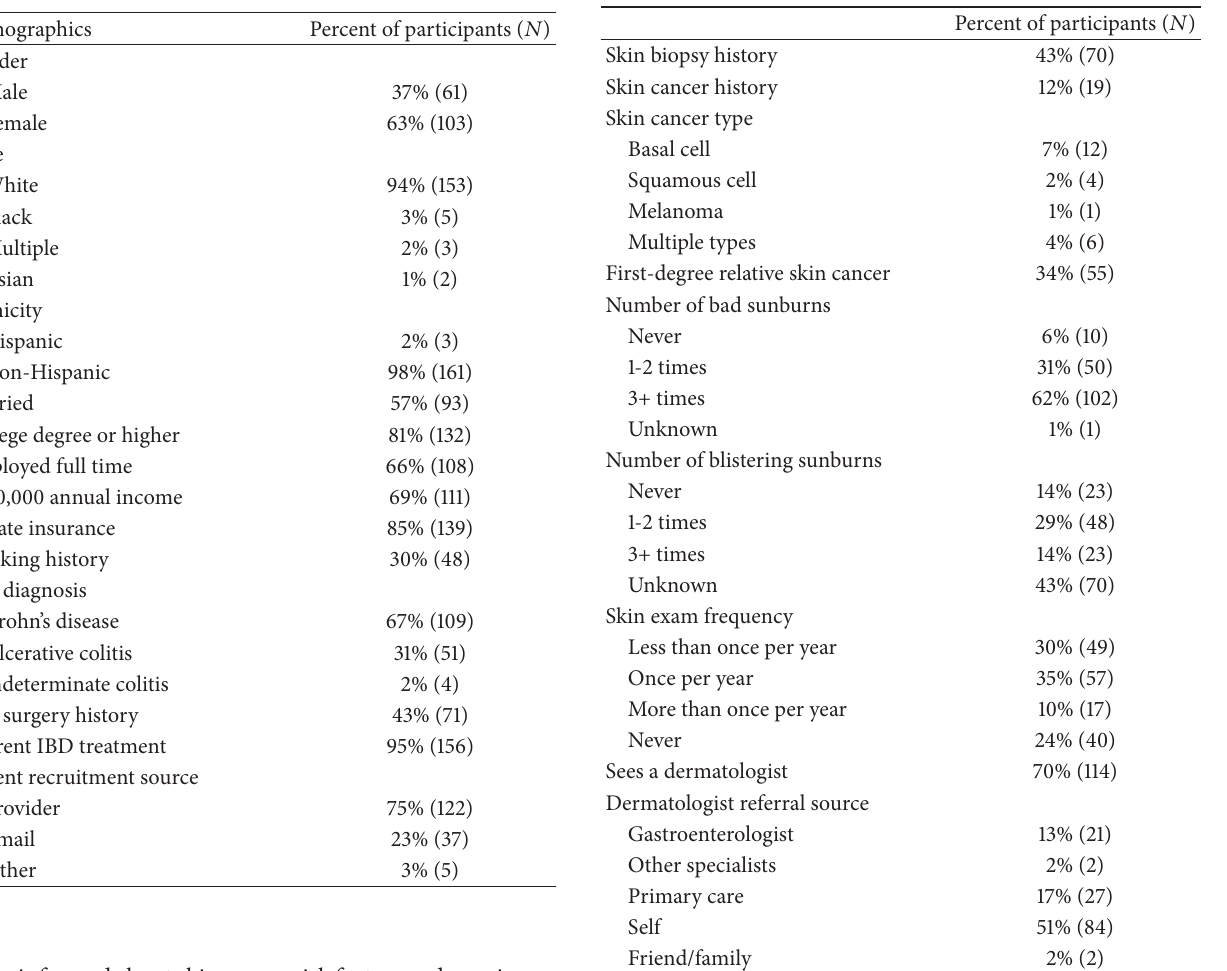
Table 2: Patient demographics. Table 3: Patient skin cancer